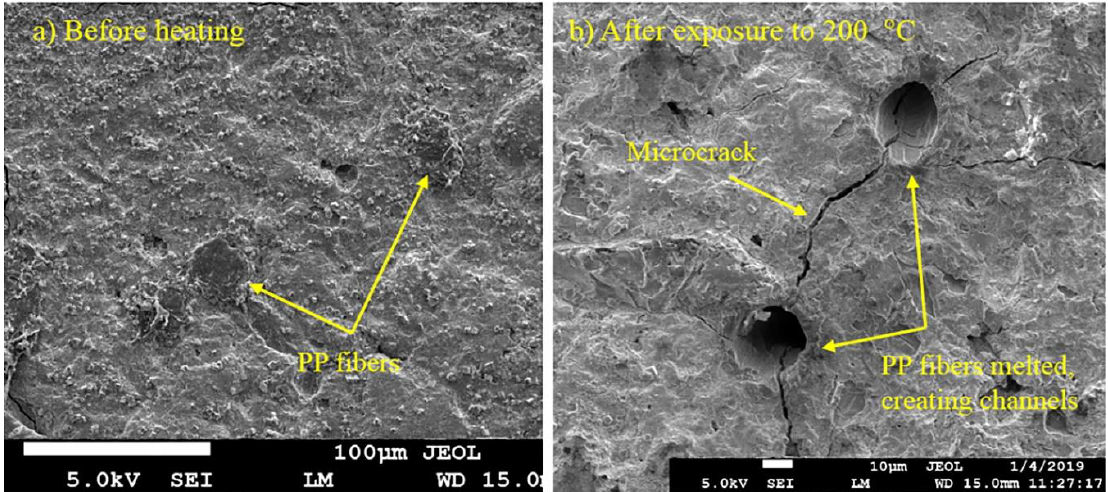
Figure 12. Comparison of preheating and post-heating exposure of FRAC microstructure reinforced with PP fiber. ( a ) The micrograph shows that before heating the PP fibers are embedded in cement mortar and no sign of cracks. ( b ) The micrograph shows few microcracks and channels in concrete matrix due to the melting of PP fiber after heating to 200 °C. Copyright permission is obtained from [143].